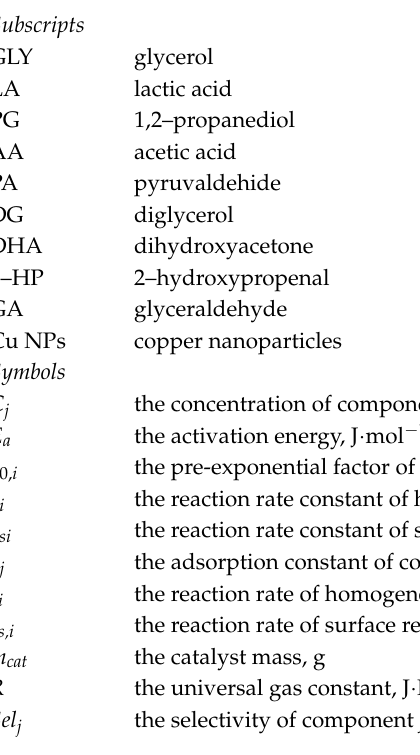
Figure S1: XRD patterns of Cu NPs catalyst, Figure S2: EDS of Cu NPs catalyst, Figure S3: SEM image and particle size distribution of Cu NPs catalyst, Table S1: Composition of the gas phase in the course of glycerol conversion, Table S2: Effect of stirring speed on glycerol conversion in the presence of NaOH, Table S3: Effect of stirring speed on glycerol conversion in the presence of Cu NPs and NaOH, Table S4: Parameters for calculating the Weisz–Prater criterion, Table S5: Results of repeated experiments with NaOH, Table S6: Results of repeated experiments with Cu NPs catalyst in the base